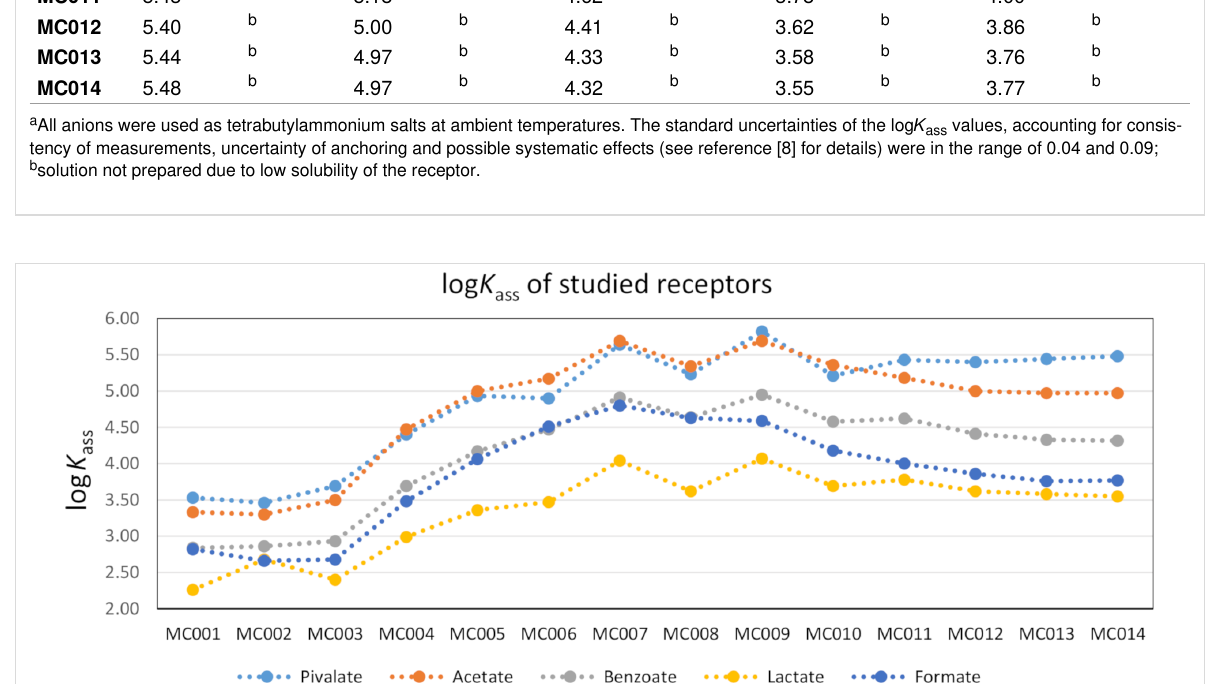
As expected, the increase of water content in DMSO reduced binding affinities. The reduction was not uniform for the differ- ent anions. According to Table 1, it was related to the hydrophi- licity of the ions – in the case of smaller and more hydrophilic anions the reduction was more significant. A comparison be- tween all anions was possible with receptor MC009 . The binding strength reduction with MC009 was 1.95 with acetate, 1.75 with formate, 1.34 with lactate, and 1.22 with both pivalate and